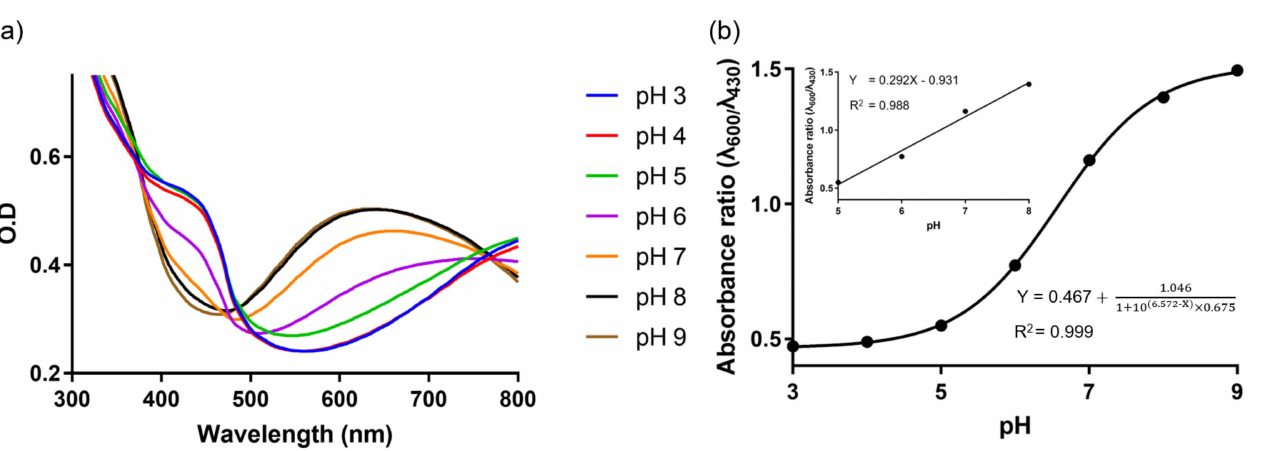
Figure 2. ( a ) Absorbance spectra of the PAni-NP solutions with varying pH. ( b ) Absorbance ratio ( λ 600 / λ 430 ) of the PAni-NP solutions from pH 3 to 9. Inset shows the absorbance ratio of PAni-NP solutions from pH 5 to 8, exhibiting good